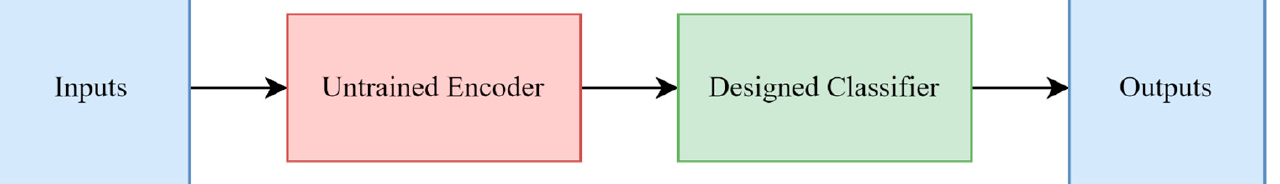
Figure 10. A simple presentation of classifier included by the untrained encoder, which is the only difference, compared to Figure 4.